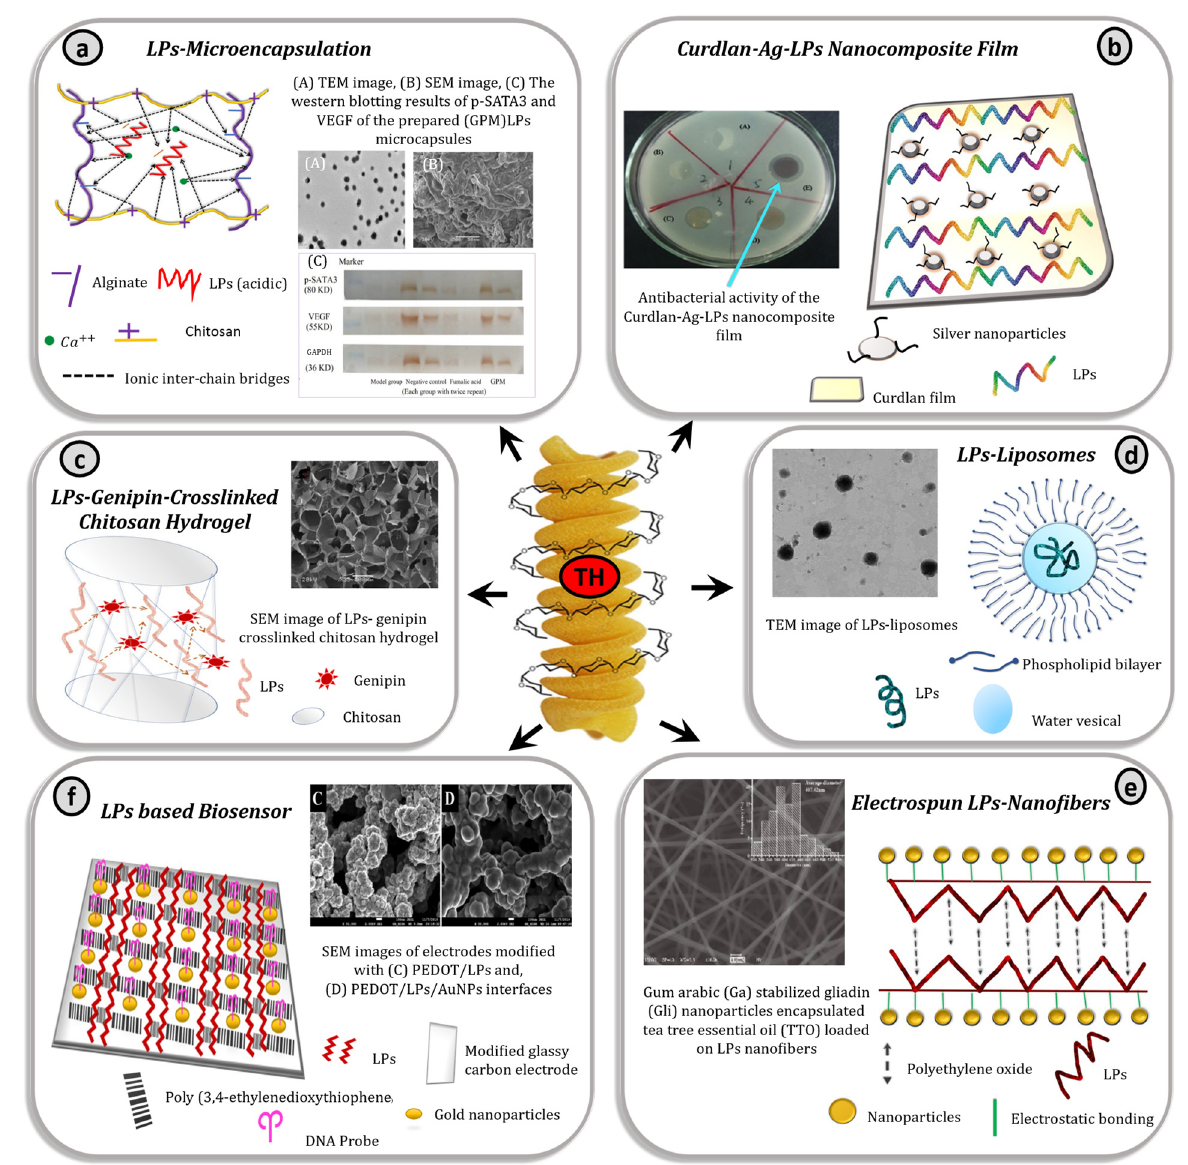
Figure 5. Corresponding results LPs-based formulations. ( a ) LPs based microencapsulation (specu- lated diagram) and results A, B, and C obtained from [40], ( b ) LPs based nanocomposite film (diagrammatic concept adopted), and the experimental results obtained from [105], ( c ) LPs based hydrogel (speculated diagram) and result obtained from [106] ( d ) LPs based Liposome (speculated diagram), and experimental result obtained from [107], ( e ) LPs based electrospun nanofiber (specu- lated diagram), and experimental result obtained from [109], ( f ) LPs based biosensor (diagrammatic concept adopted), and results obtained from [111]; TH; diagrammatic concept of triple helix structure of LPs.